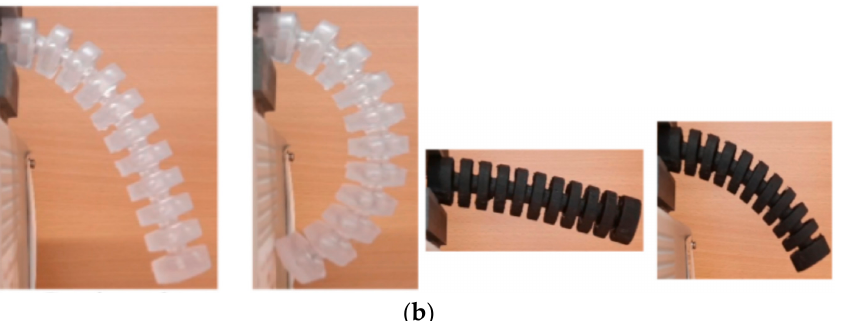
Figure 4. Joints in macro and microscale: ( a ) Testing of the wire-driven robot arm. Reprinted with permission from Ref. [124]. Copyright 2019 MDPI. ( b ) Experiments on bending deformation due to applied pressure from an omnidirectional soft pneumatic actuator. Reprinted with permission from Ref [94]. Copyrights 2021 Elsevier.